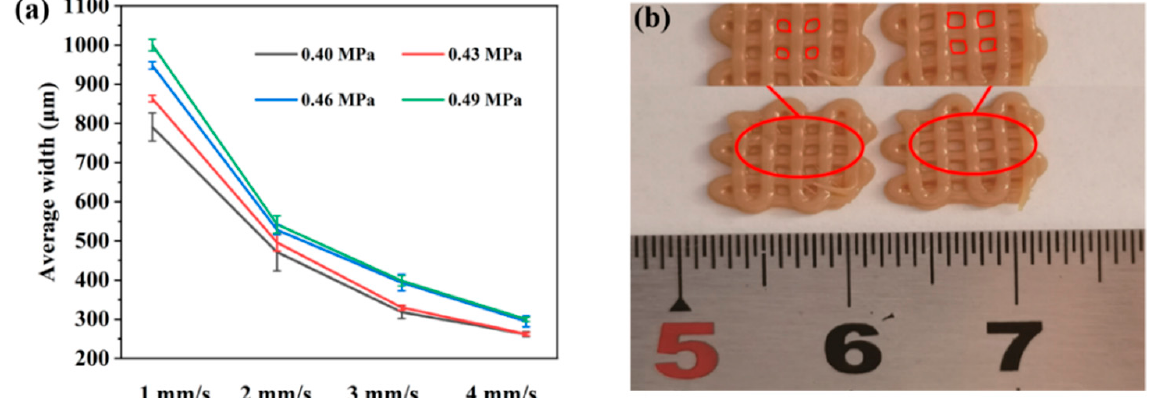
Figure 5. The printable parameters of ink: ( a ) the widths of the single filaments when the speed of the nozzle was 1–4 mm/s and the extrusion pressure changed from 0.40 MPa to 0.49 MPa; ( b ) the pull interaction between the filaments (the z-spacing of the two left and two right parameters are 0.4 mm and 0.6 mm, respectively).